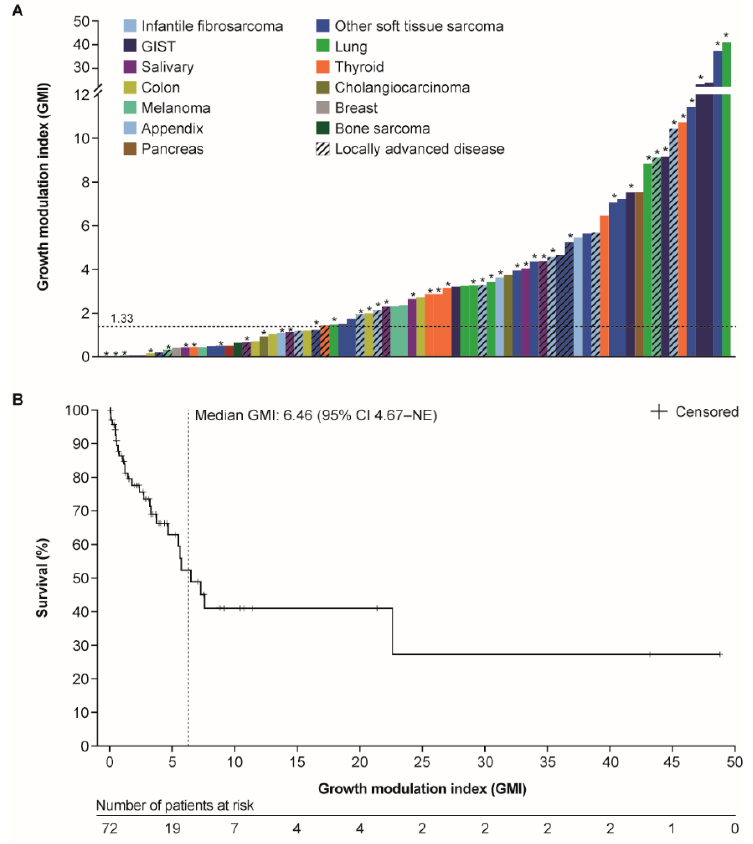
Figure 2. ( A ) Waterfall plot of individual patient growth modulation indices for the overall cohort (locally advanced or metastatic disease ( n = 72)) by tumor type; ( B ) Kaplan–Meier estimate of median GMI. GMI was defined as the ratio of progression-free survival on larotrectinib (independent review